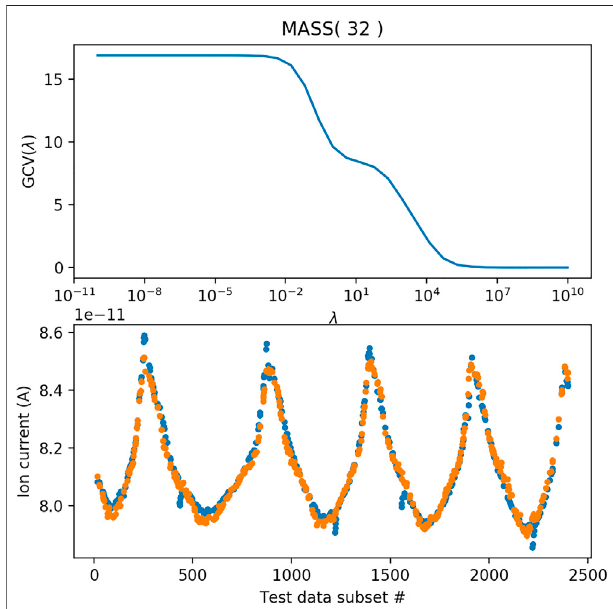
FIGURE 8 | Test of the GAM solution using a range of values for the penalty term λ in Eq. 9 . Orange circles represent the GAM reconstruction and blue circles represent the raw ion current during in-situ calibration.